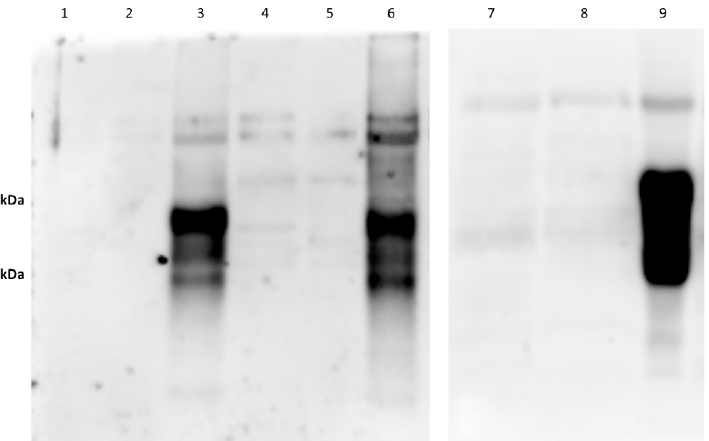
Figure 4. Results of WB analyses carried out with the anti-PrP MAb F89/160.1.5 on the pellets obtained after ultracentrifugation of brain tissue samples from one negative control ( B. ceti -uninfected) striped dolphin found stranded along the Tyrrhenian coast of Tuscany (lanes 1–3), as well as from two B. ceti -infected, neurobrucellosis-affected striped dolphin specimens found stranded along the Italian coast of Apulia (lanes 4–6) and in Canary Islands (lanes 7–9), respectively. The typical 35 kDa and 26 kDa PrP c bands are shown at lanes 3, 6 and 9 after ultracentrifugation, while lanes 2, 5 and 8 show the WB results obtained after PK digestion, and lanes 1, 4 and 7 after treatment with deglycosydase F (original Western blot figures are in Figures S4a,b).